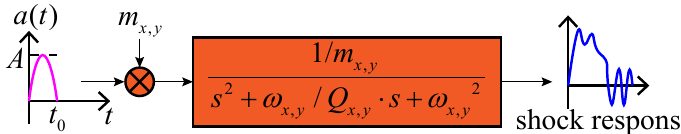
Figure 7. Simulink model of the shock response of the MEMS gyroscope without the stopper mechanism.